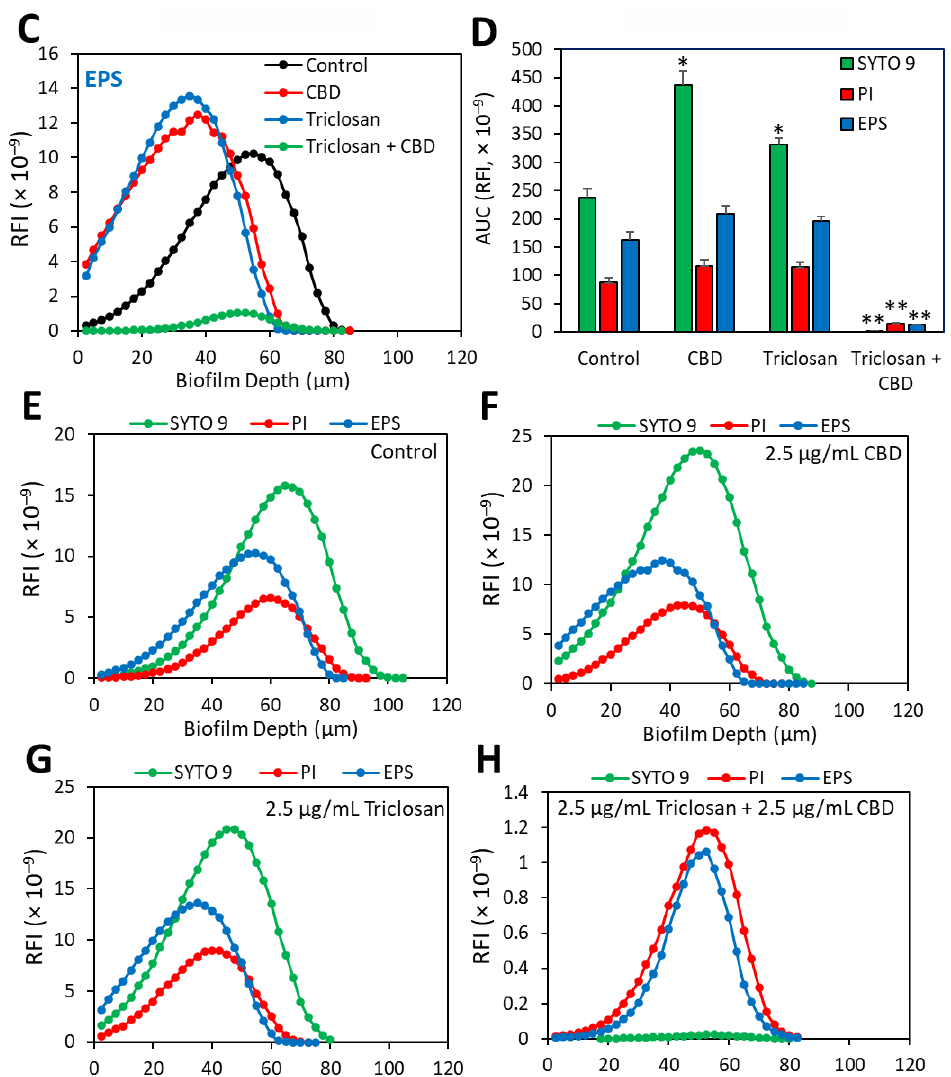
Figure 10. Quantification of the relative fluorescence intensities (RFIs) of SYTO 9, PI and fluorescent Dextran in the SDCM images of biofilms formed after a 24 h incubation with 2.5 µ g/mL triclosan and/or 2.5 µ g/mL CBD and control bacteria grown under the same conditions in the absence of the compounds. ( A – C ) The relative fluorescence intensity of SYTO 9 ( A ), PI ( B ) and fluorescent Dextran 10,000 ( C ) in control (black line), 2.5 µ g/mL CBD (red line), 2.5 µ g/mL triclosan (blue line) and 2.5 µ g/mL triclosan + 2.5 µ g/mL CBD-treated (green line) bacteria. ( D ) The average of the area under the curve (AUC) of the RFI in 4-5 different images of control or the treatment group. * p < 0.05 compared to control. ** p < 0.01 compared to control and the individual single treatments. ( E – H ) The relative fluorescence intensity of the three dyes in the four different groups: Control ( E ); 2.5 µ g/mL CBD ( F ); 2.5 µ g/mL triclosan ( G ) and 2.5 µ g/mL triclosan + 2.5 µ g/mL CBD ( H ). The red fluorescence of PI representing the dead bacteria become prominent after combined treatment of triclosan with